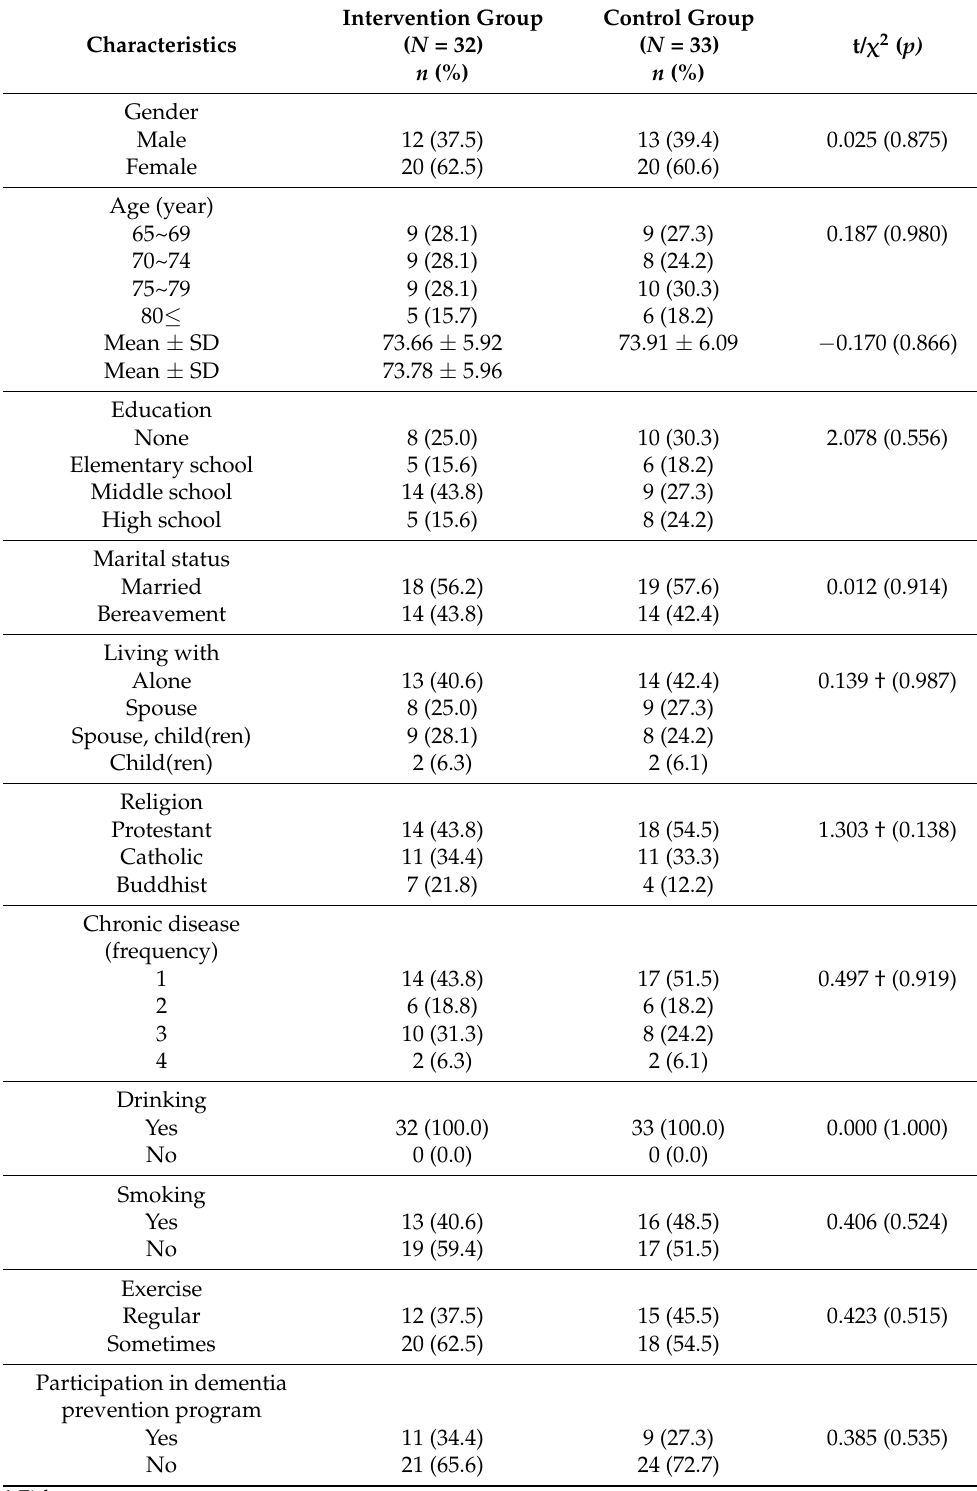
Table 2. General characteristics of the study participants and homogeneity.